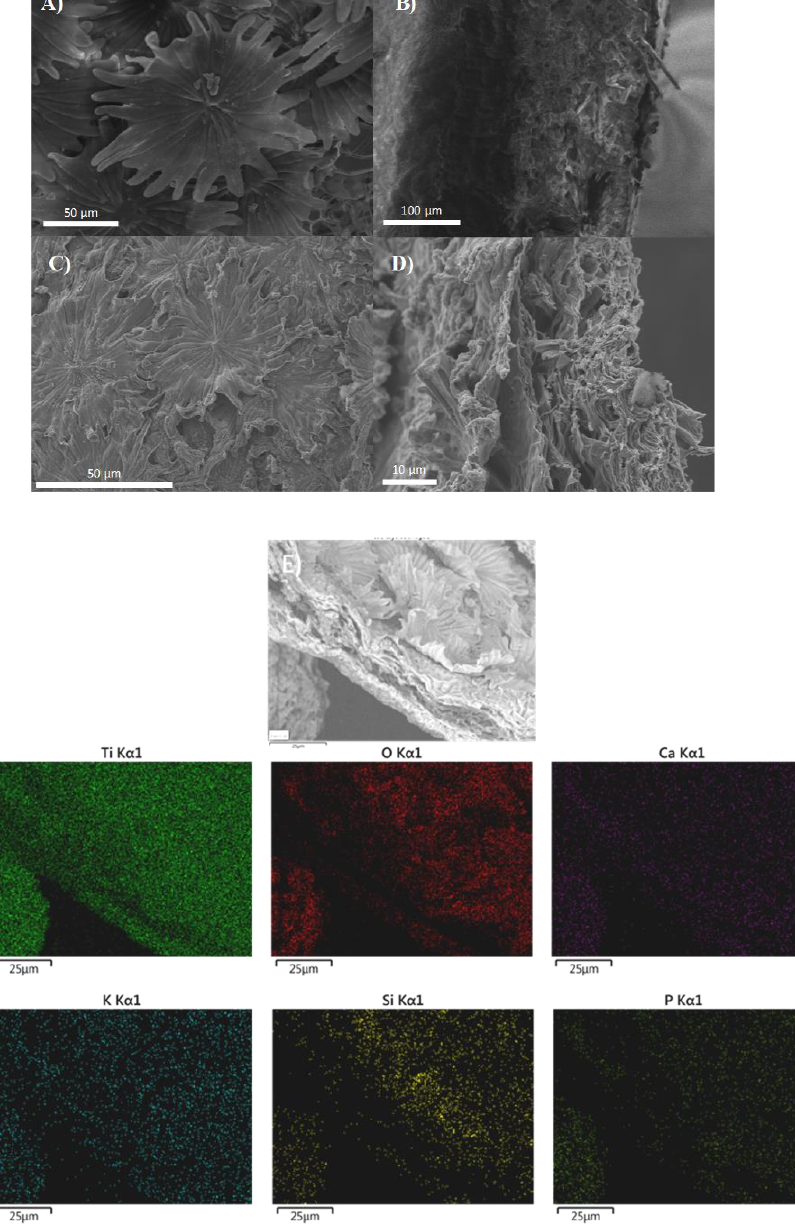
Figure 4. SEM images of a fresh olive leaf ( A , B ) and the artificial olive leaf ( C , D ). ( E ) Elemental mapping (SEM-EDX) of AOL sample indicating the distribution of Ti, O, Ca, K, Si and P.